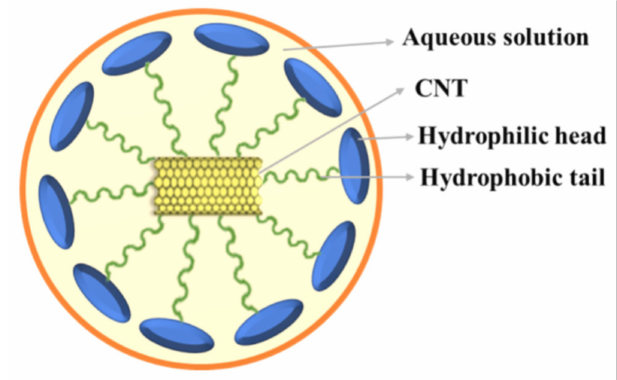
Figure 4. Wrapping process of PVP on the surface of CNTs.